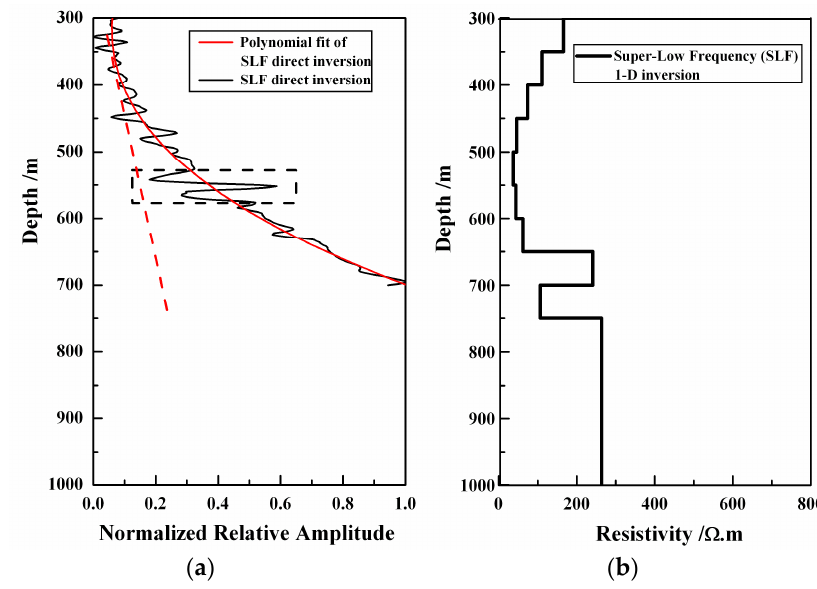
Figure 15. ( a ) Direct depth transformation and ( b ) the one-dimensional regularization inversion results of Well 1-4.